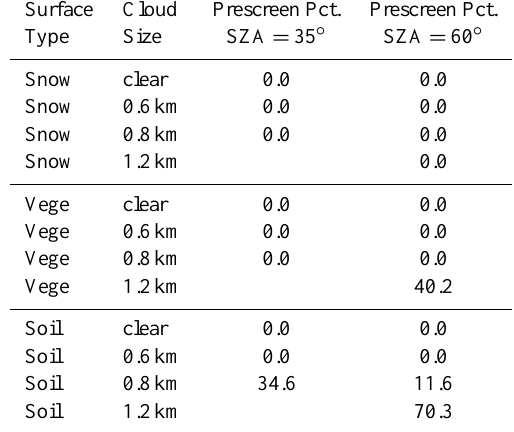
Table 3. Percentage of simulated observations identified as cloudy by prescreener